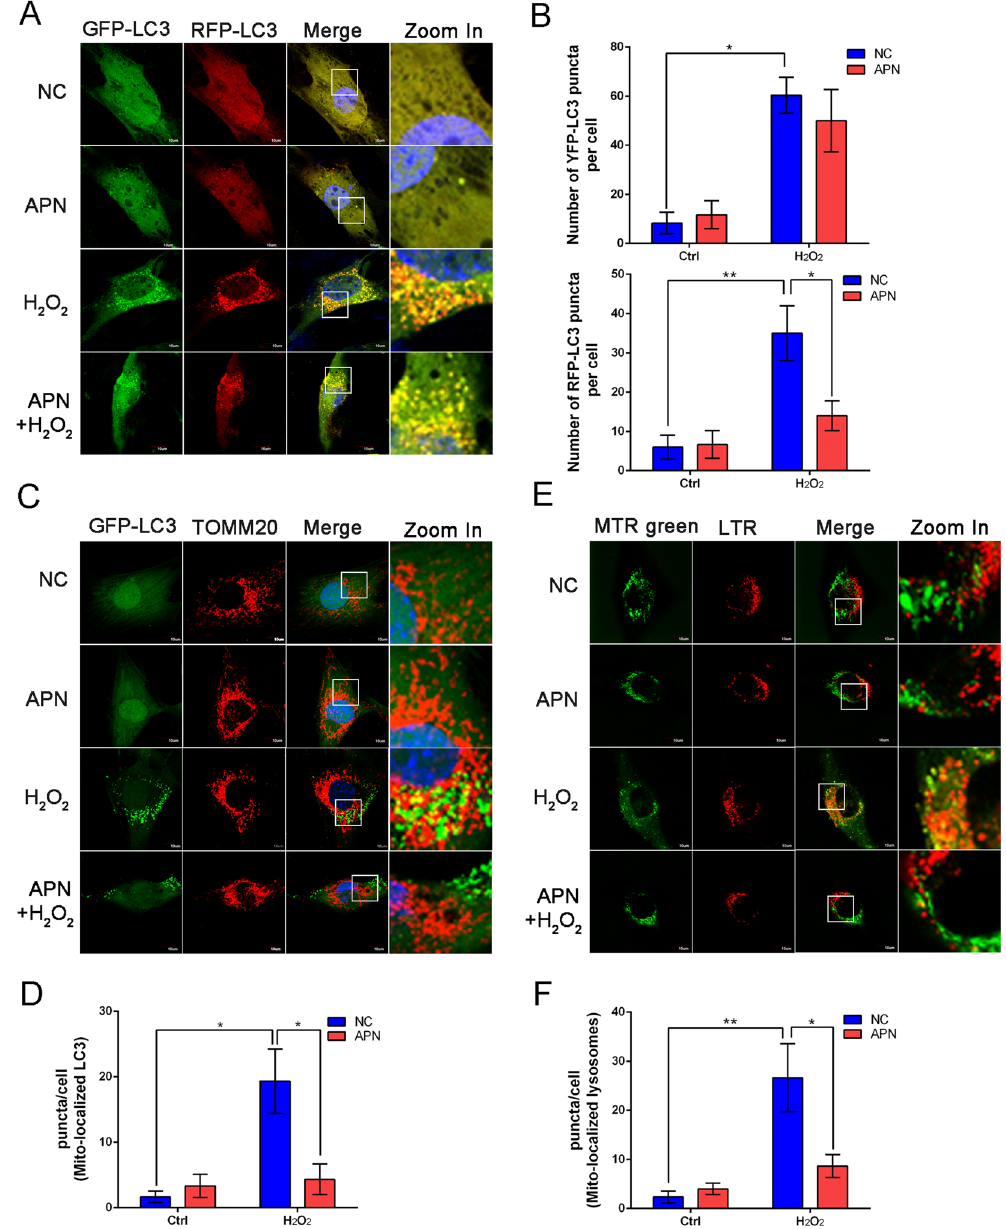
Figure 4. APN partially blocks the colocalization of mitochondria and autophagosomes/lysosomes. ( A ) C2C12 cells were transfected with Ad-mRFP-GFP-LC3 for 24 h, followed by incubation with 30 μ g/mL APN for 24 h, and finally incubated with or without 5 mM H 2 O 2 for 1 h. The distribution of YFP (RFP + GFP + )- or RFP (RFP + GFP − )-LC3 puncta was visualized by confocal microscopy. Scale bar, 10 μ m. ( B ) Quantitative analysis of YFP- and GFP-LC3 puncta, which represent autophagosomes and autolysosomes, respectively (mean ± SEM; n = 100 cells from 3 independent experiments, * p < 0.05, ** p < 0.01). ( D ) C2C12 cells transfected with GFP-LC3 were treated with or without 5 mM H 2 O 2 for 1 h, followed by staining with MitoTracker Red for mitochondria and confocal microscopy to visualize GFP-LC3 puncta. Scale bar, 10 μ m. ( E ) Quantification of GFP-LC3 punctate structures associated with mitochondria (TOMM20) described in ( D ) (mean ± SEM; n = 100 cells from 3 independent experiments, * p < 0.05). ( E ) Representative fluorescence images of MitoTracker Green FM (MTR green) and LysoTracker Red (LTR) in C2C12 cells treated with or without 5 mM H 2 O 2 for 1 h. Scale bar, 10 μ m. ( F ) Quantitative analysis of cells that contained fragmented mitochondria- localized lysosomes from three independent experiments (mean ± SEM; n = 100 cells, * p < 0.05, ** p <